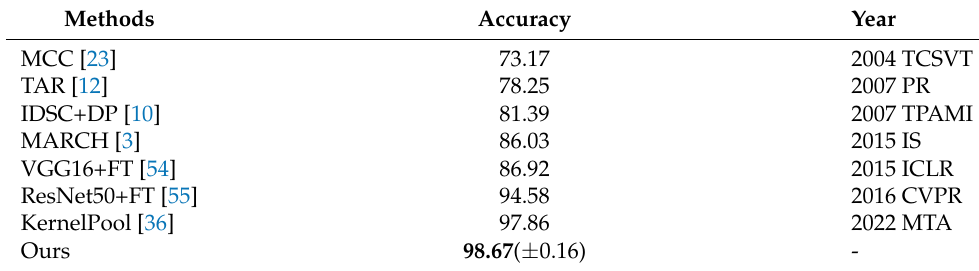
Table 6. Classification accuracy (%) comparison on ICL dataset with identical settings.